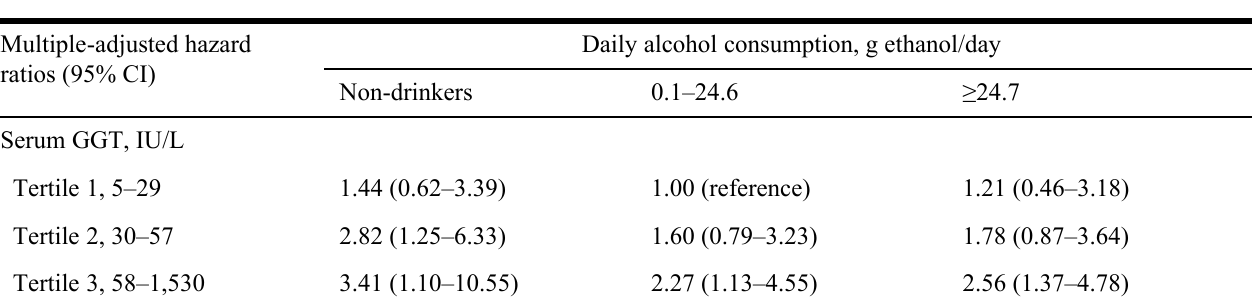
Figure 1. Multiple-adjusted hazard ratios for persistent proteinuria according to joint categories of daily alcohol consumption and serum GGT. Multiple-adjusted hazard ratios were calculated after adjustment for age, body mass index ( < 18.5, 18.5 – 24.9, 25.0 – 29.9, ; 30.0), fasting plasma glucose, smoking habits (nonsmokers, past smokers and current smokers), regular leisure-time activity (yes / no), and hypertension (yes / no). * : P < 0.05, ** : P < 0.01. CI, con fi dence interval; GGT,